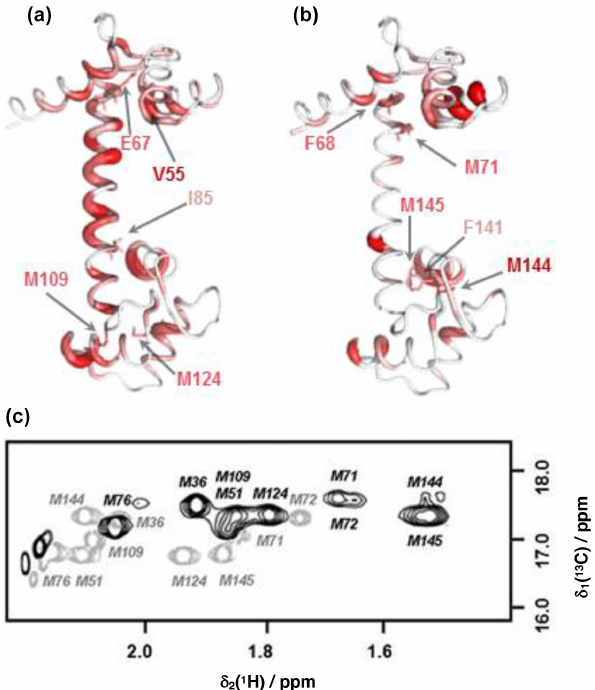
Figure 4. Comparison of backbone and side-chain chemical shift changes in CaM resonances upon binding idoxifene. (a) and (b) : heat map representations of CaM chemical shift changes upon idox- ifene binding, shown for clarity using the coordinates of the unli- ganded CaM X-ray structure, 1cll. The hydrophobic pocket of the N terminus at the top and the rear of the C-terminal hydropho- bic pocket is at the bottom. In (a) residues are coloured accord- ing to the weighted average (WA) backbone shift changes observed in the idoxifene : CaM complex, with gradation from white (WA shift = 0.0ppm) to red (WA shift > 0.7ppm) and the broadest rib- bon indicating the maximum shift changes. The locations of M109 and M124 by the hydrophobic pocket of the C domain are indi- cated. Residues I85 and E67 are indicated, as they define the central portion of the flexible tether joining the two domains. The position of V55, which undergoes a large shift change as in the CaM : M13 complex, is also indicated. In (b) residues are coloured according to the largest side-chain 1 H shift changes observed upon idoxifene binding (shifts > 0.50ppm), with colour gradation and ribbon width depicted as in (a) . The locations of key residues such as three of the nine methionines in the vicinity of the hydrophobic pockets and F68 and F141 are indicated. (c) A 2D 13 C CT-HSQC spectrum showing the ε methyl methionine signals of free CaM (grey) and idoxifene- bound CaM (black).